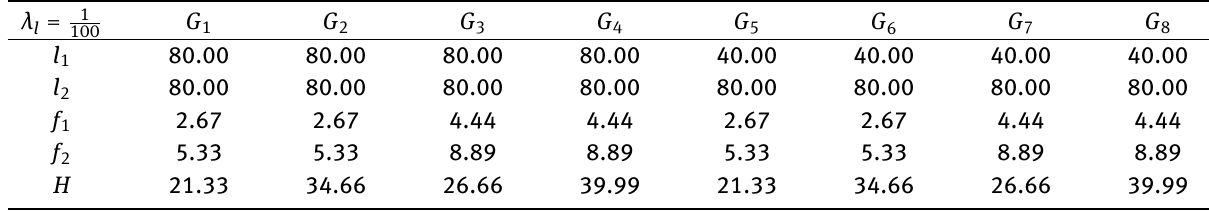
Table 1: Geometrical sample, dimensions in m. For the definition of the different variables refer to Figure 1 λ l = 1